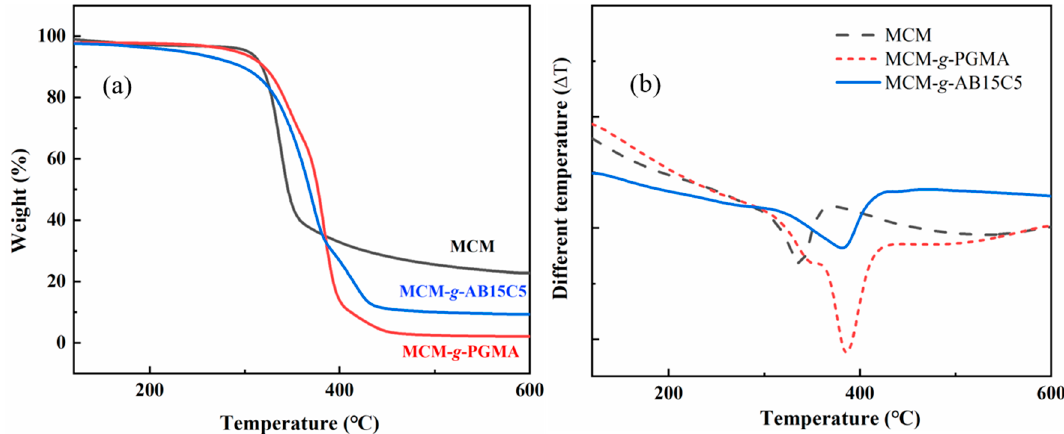
Figure 3. TGA curves ( a ) and DTA curves ( b ) of MCM, MCM- g -PGMA and MCM- g -AB15C5.